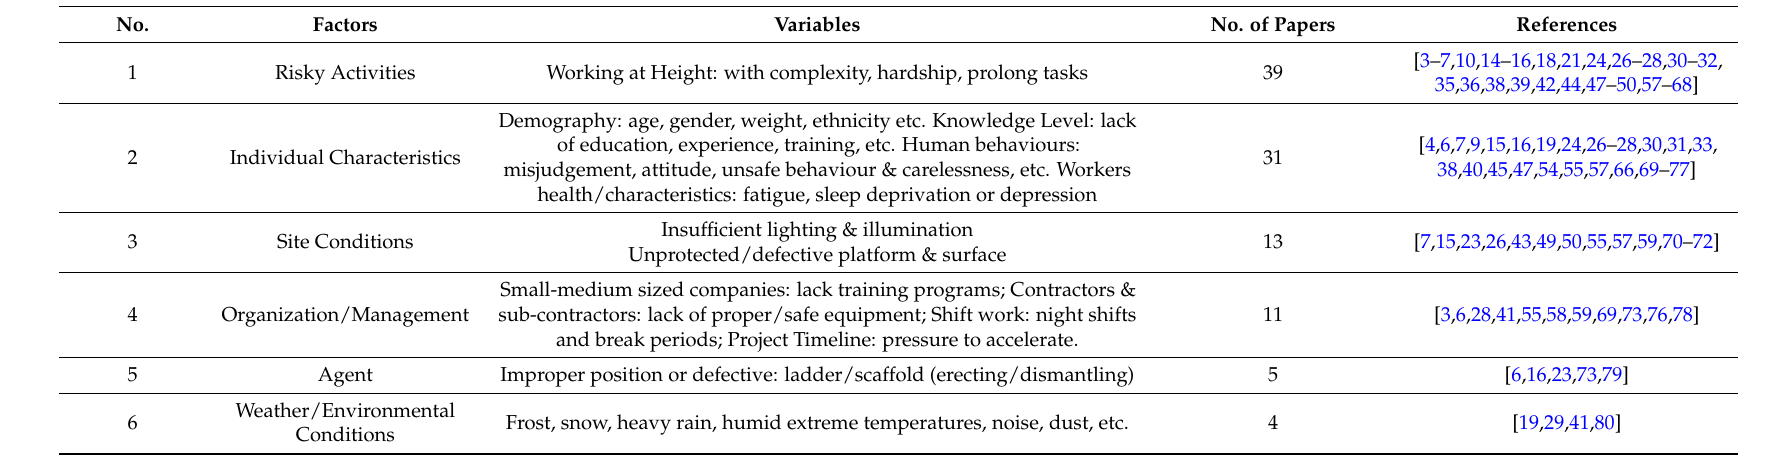
Table 10. Leading Factors for FFH